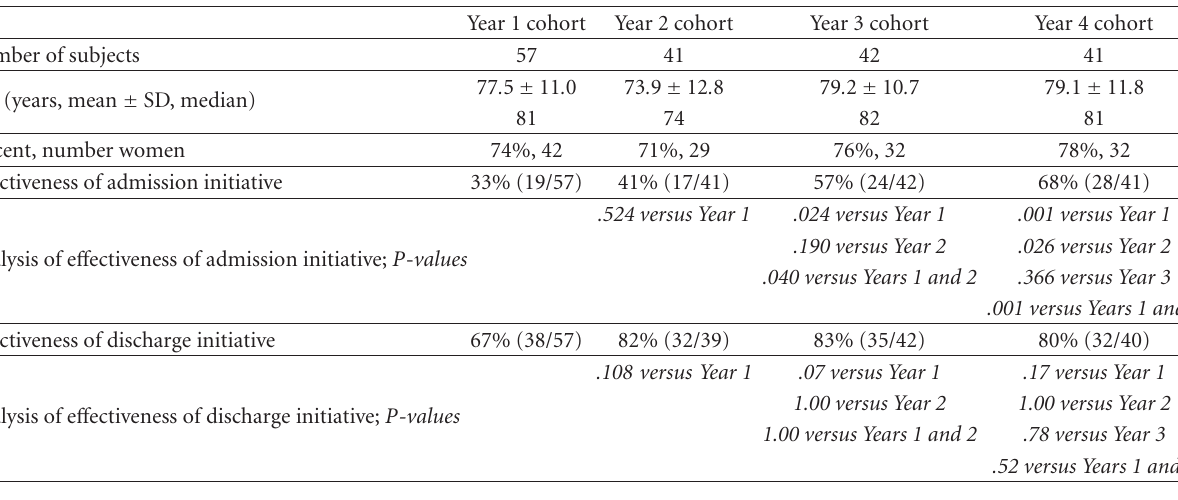
Table 1: Comparison of e ff ectiveness of B-FIT admission and discharge initiatives in subjects admitted with hip fragility fracture. (i) Admission initiative was introduced early in Year 1; (ii) admission initiative was modified early in Year 2 with a computer-assisted reminder; (iii) discharge initiative was introduced one year before Year 1 with computer-based